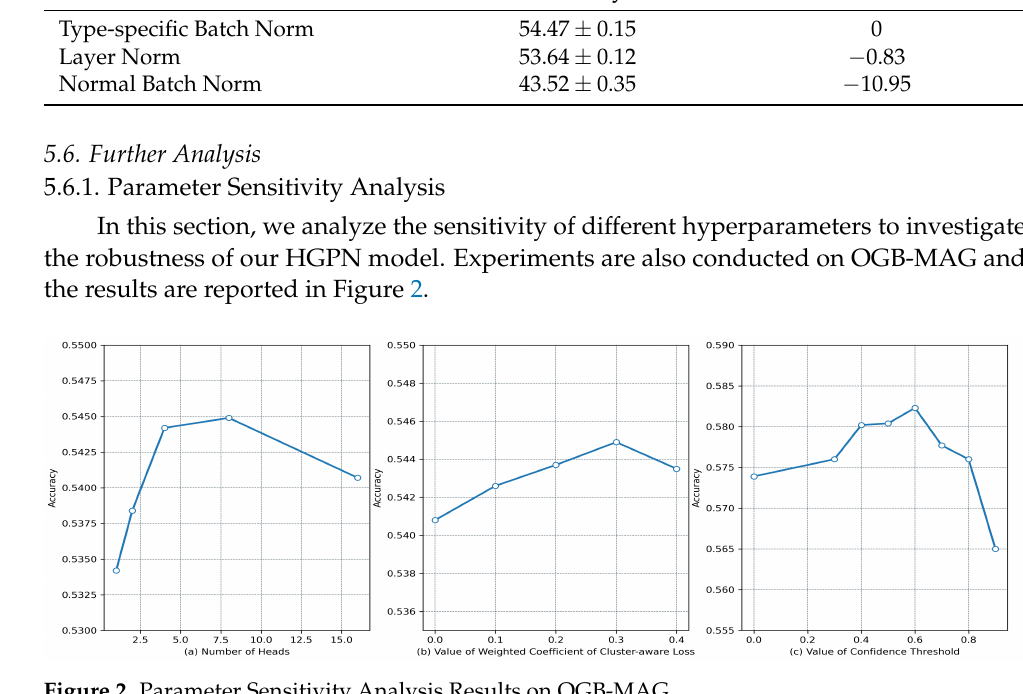
Figure 2. Parameter Sensitivity Analysis Results on